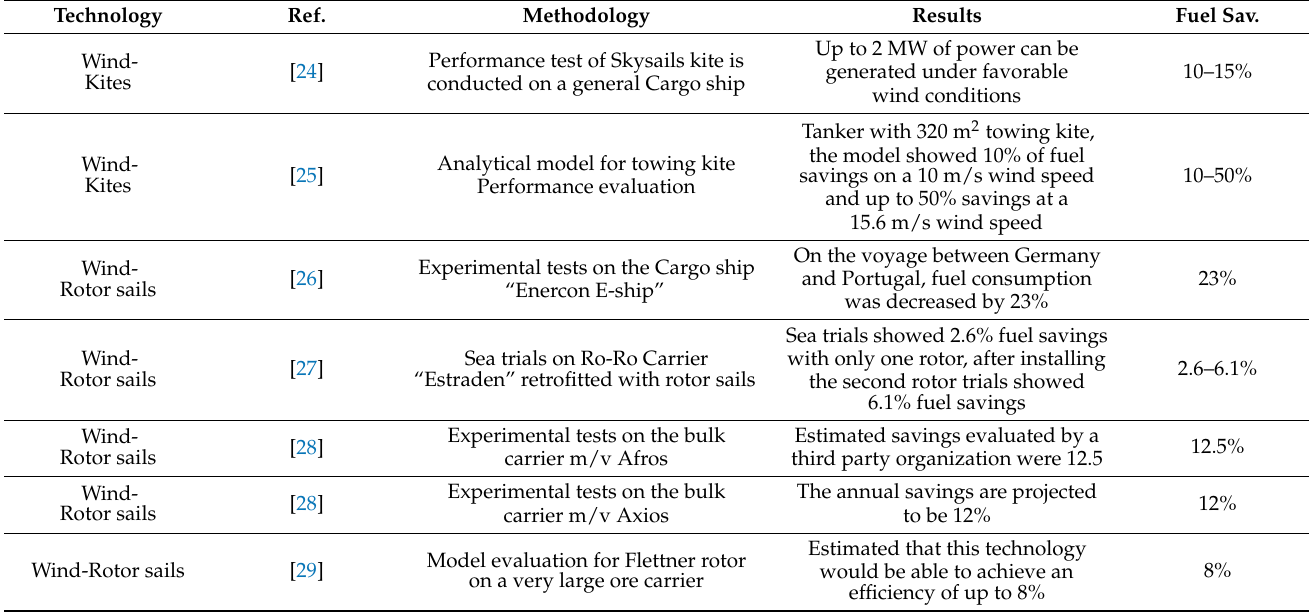
Table 1. Overview of wind and solar energy